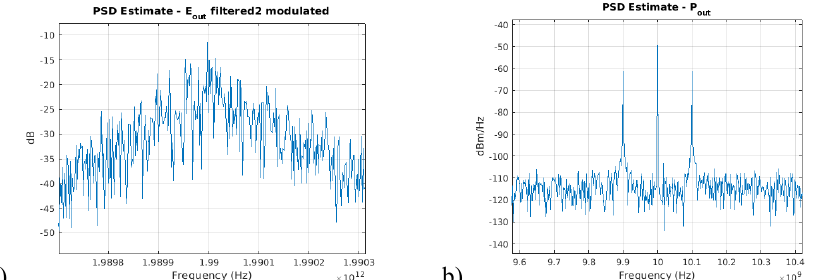
Fig. 7. Spectral density of the optical mode with amplitude modulation (a) and the output signal of the photodetector (b) in the formation of a modulated microwave signal using a laser with a linewidth much larger that the modulation